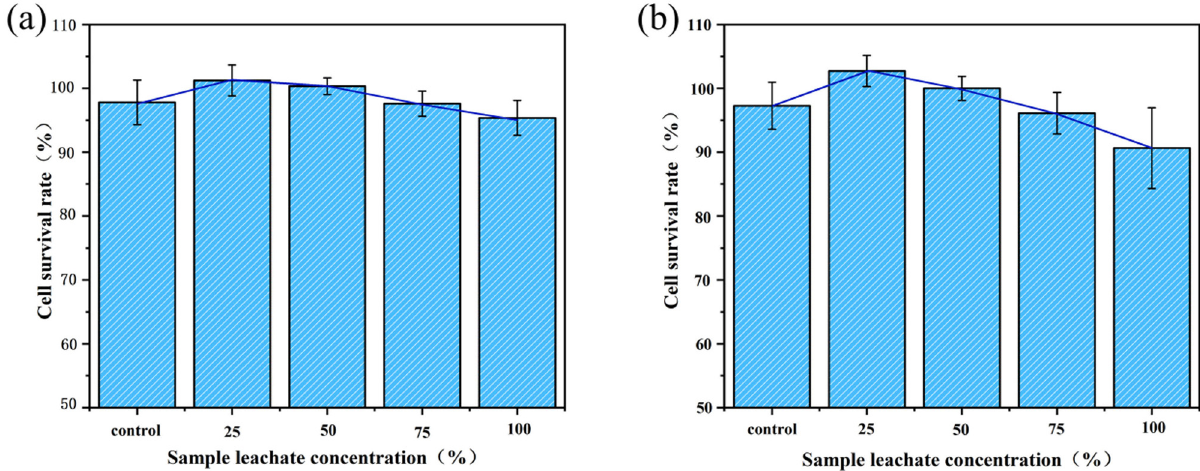
Figure 8: Cell survival rate of SF fi lm: ( a ) pure SF fi lm and ( b ) SF/PEDOT